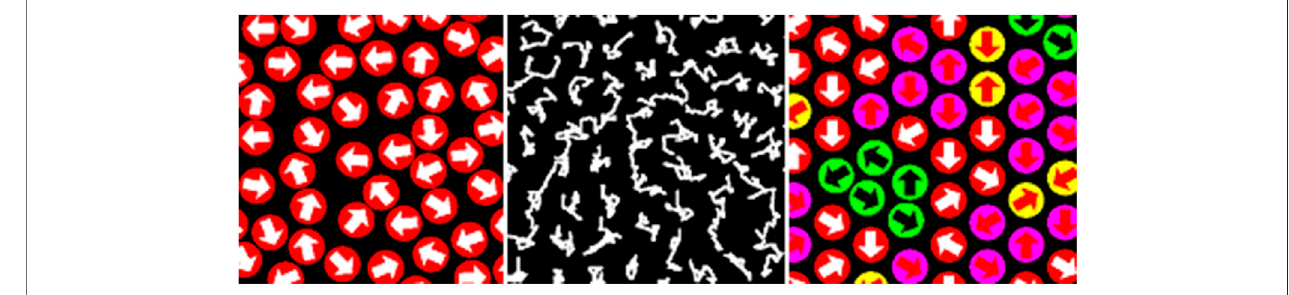
FIGURE 1| The scheme ofmolecular dynamics simulations of hard disks (left) , trajectories of simulated hard disks (middle), and a scheme of cooperative loops in the dynamic lattice liquid model (right) : green – a cooperative motion is possible, yellow, red and pink – no cooperative loop of motion.